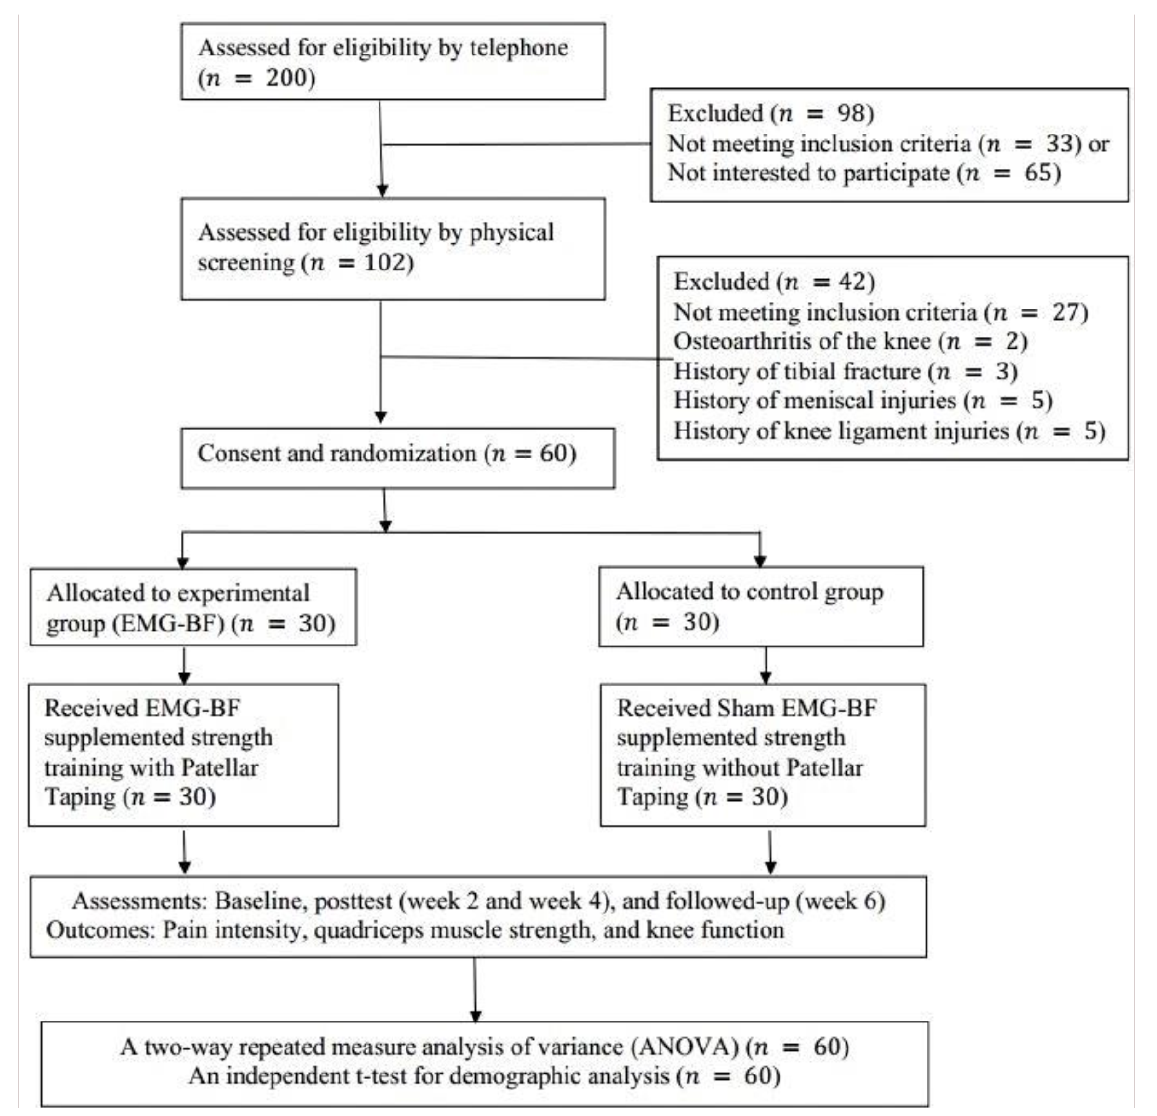
Figure 1. Consolidated Standards of Reporting Trials (CONSORT) diagram showing flow of participants through each stage of a randomized trial. EMG-BF, electromyographic